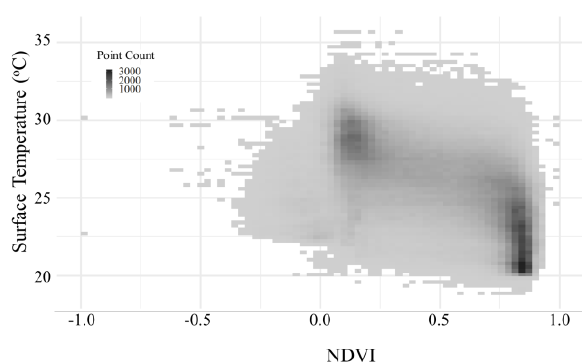
Figure 2. Collinearity between NDVI and Surface